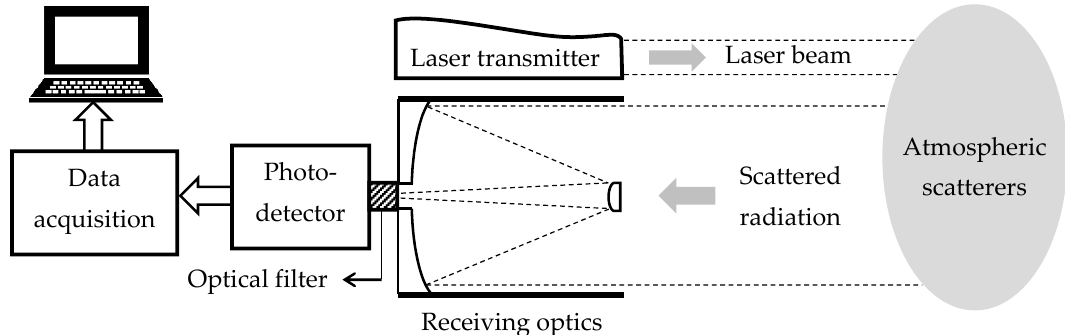
Figure 1. Basic schematics of a lidar system: A laser transmitter emits light pulses to the atmosphere; an optical assembly, usually a telescope, collects part of the scattered radiation, which, after being filtered, is brought onto a photo-detector; the detected signal is then amplified, digitized and processed to retrieve atmospheric parameters.